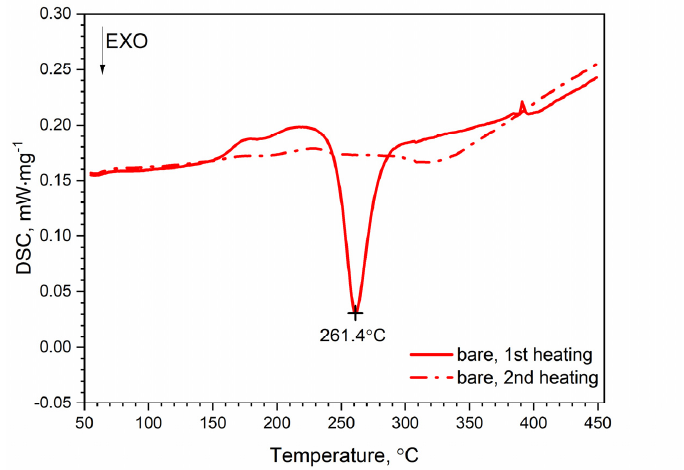
Figure 7. DSC thermograms of bare AW-2024-T3.